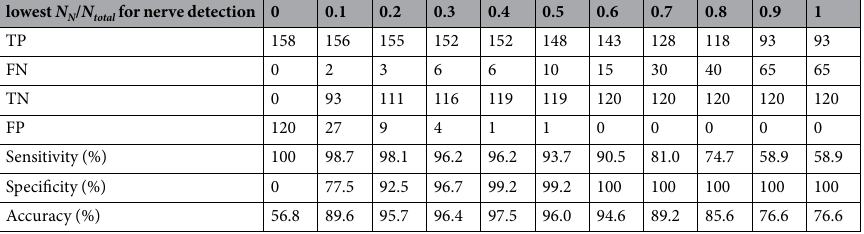
Table 2. Results of peripheral nerve detection using N N / N total . TP: true positive. FN: false negative. TN: true negative. FP: false positive. Note: The average and the standard deviation of N total for the total 278 tissues were 6.0 and 1.9,